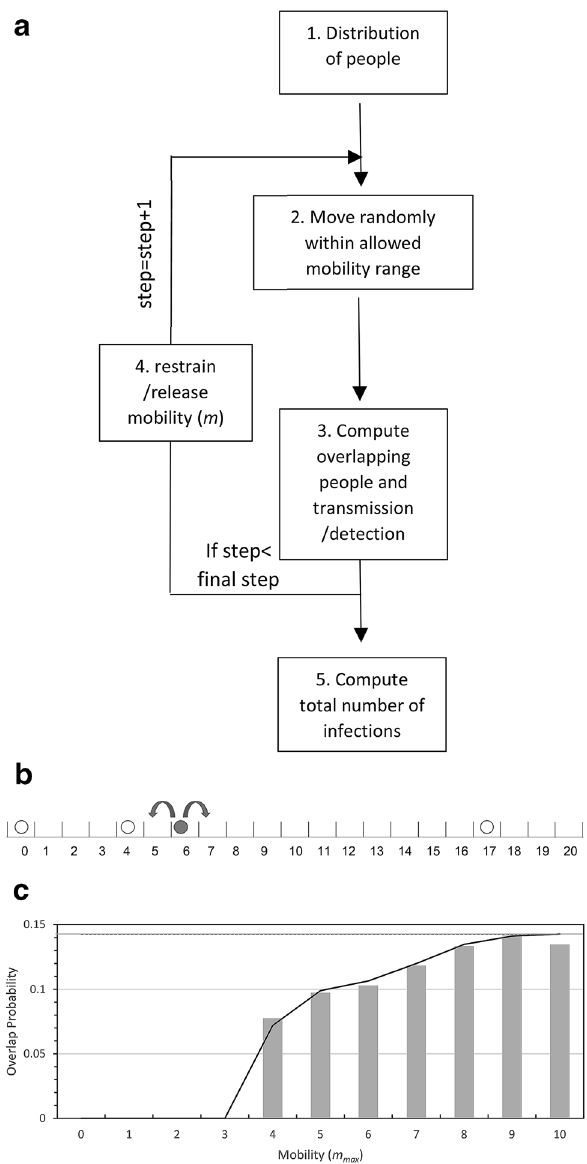
Figure 1. ( a ) Schematic algorithm of the simulation. The main steps are as follows: 1. M (= 1000) people are distributed on a one -dimensional grid having N sites (= 2000). 2. They can move freely within a window of + /− m sites ( m was set to 100 when no confinement was enforced). m = 0 means that people were not allowed to move from their sites. 3. The people collocated at the same site were identified. People collocated with an infectious person were infected with a probability of T.P. , and the infected people were detected with a set detection probability ( D.P. ) and isolated from the system (detected people cannot infect nor be infected). 4. When the detected number of infected people reached 1% of the total number of all people (1% of 1000 people in our setting), m was decreased to the values indicated in Table 1. Infected people remained infectious for a total of 15 steps: 5 steps as a presymptomatic patient, and then ten steps as a symptomatic patient. Furthermore, we assumed that the virus would disappear after 15 steps, and that the infection occurs only once. ( b ) Schematics of the one-dimensional grid model with four people and 21 sites. The black and white circles represent the infected and the non-infected person, respectively. The arrows illustrate the possible movement of the infected person. For m = 1, the person can move by − 1, 0, or + 1. Viral transmission occurs with a probability of T.P. when an infected person occupies the same sites as a non-infected person. The periodic boundary condition implies that a person at position 21 can move to its right and will "reappear" at position 0 (and vice versa). It is used to alleviate the effects of the boundaries. ( c ) Comparison of the contact probability calculated using an exact probabilistic model (supplemental), and numerically from our simulation (average over 3000 runs with N = 3, M = 21). In the initial distribution, people were regularly-spaced at positions 0, 7, and 14 on the one-dimensional grid with a periodic boundary condition (between positions 0 and 20). People were then allowed to move according to any site elements within the mobility limit set to m max . The blue bars represent the results of the simulation, the red line those of the exact probabilistic mode, and the gray line represents the average probability of encounter for a random distribution (0.1428 for N = 3 people on a grid with M = 21